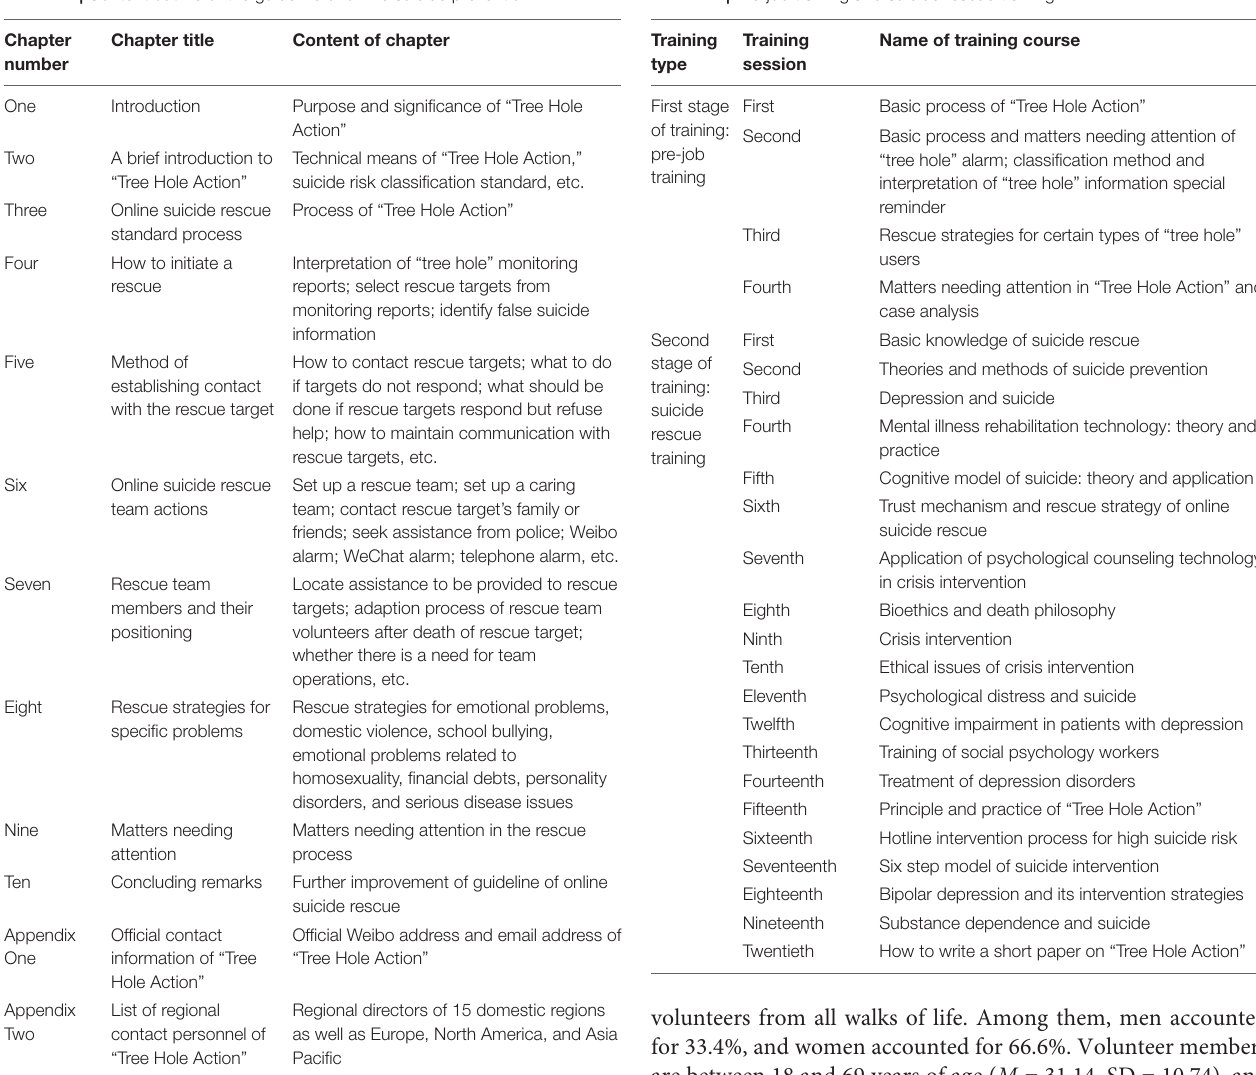
TABLE 1 | Content outline of the guideline of online suicide prevention. TABLE 2 | Pre-job training and suicide rescue